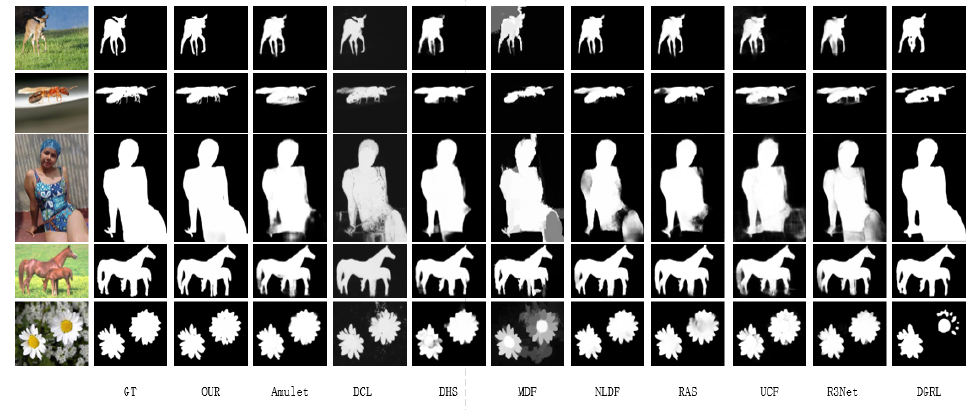
Figure 7. The visual comparison of each model on different datasets.